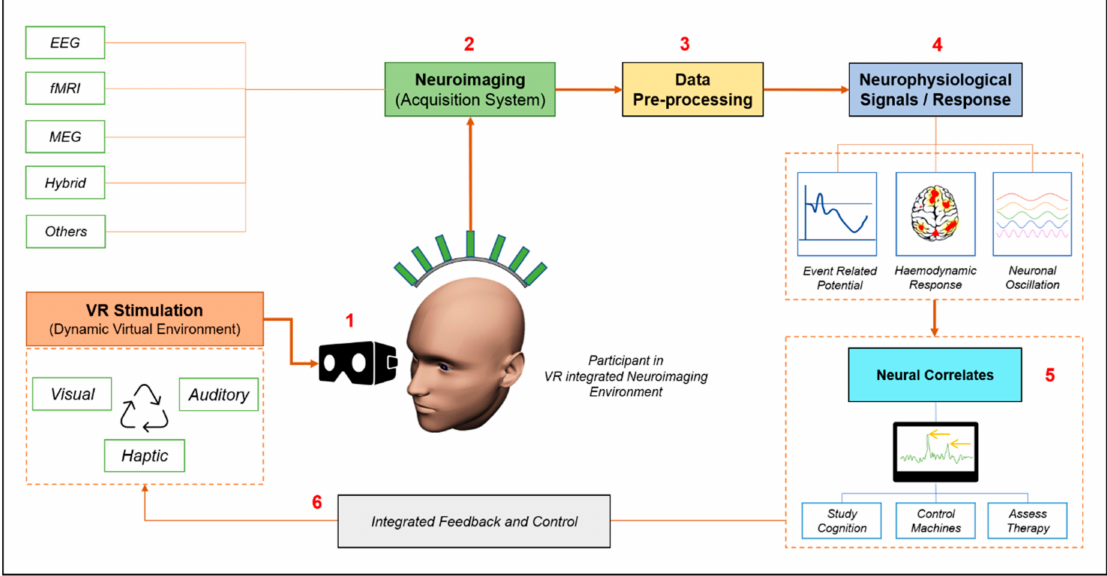
Figure 1. A brief layout of this virtual reality (VR) integrated neuroimaging